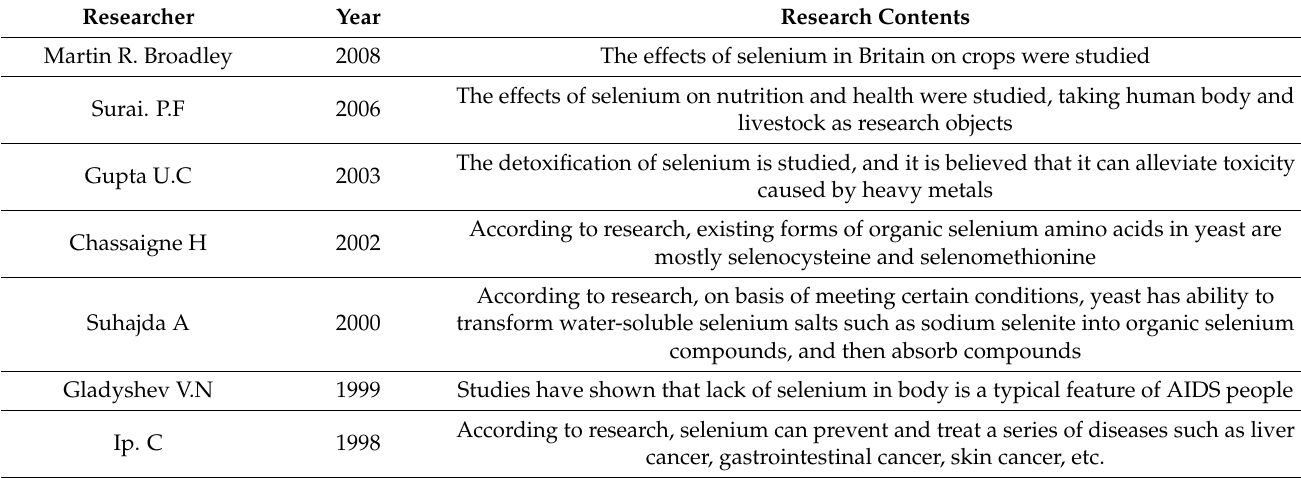
Table 1. Research Time and Content of Selenium by Foreign